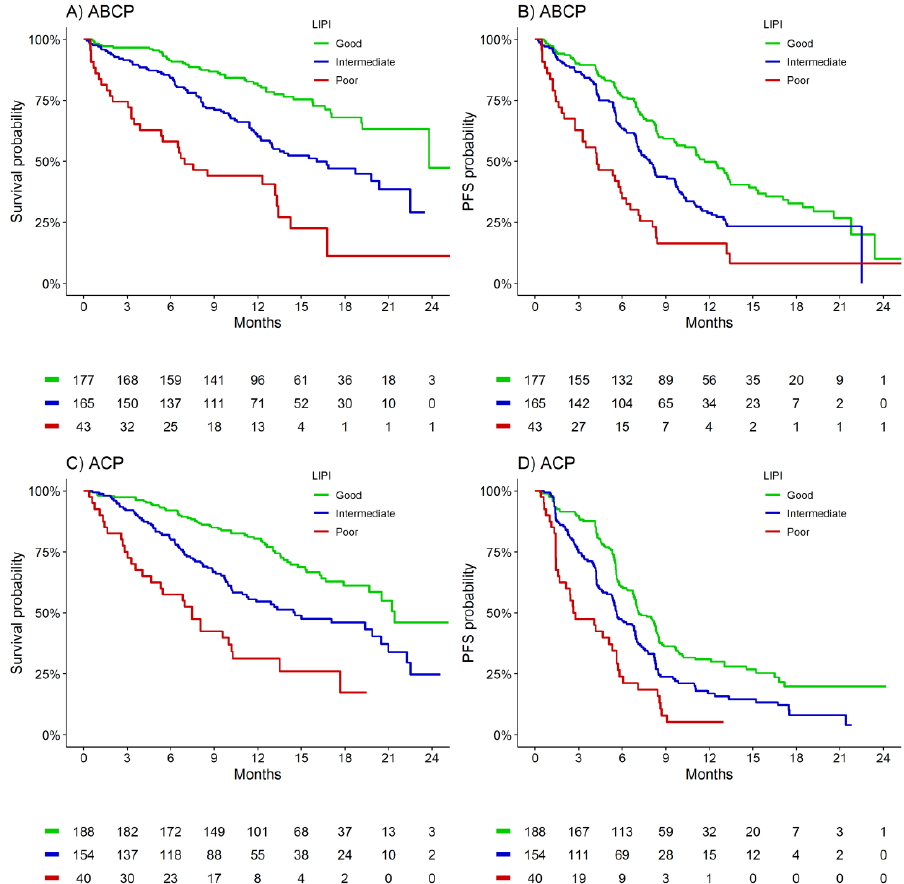
Figure 1. Kaplan-Meier estimates of overall survival and progression-free survival according to LIPI group for patients treated with ABCP or ACP. ( A ) ABCP—overall survival ( B ) ABCP—progression-free survival ( C ) ACP—overall survival ( D ) ABCP — progression-free survival.